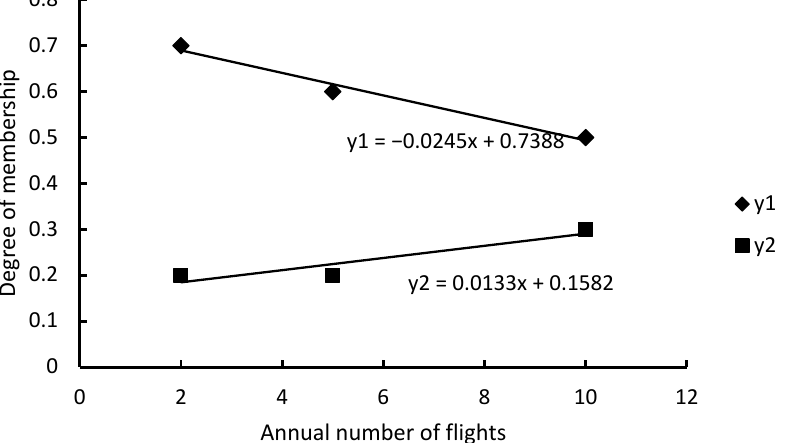
Figure A26. Single factor evaluation for the index of bad record of security check (one and more times).